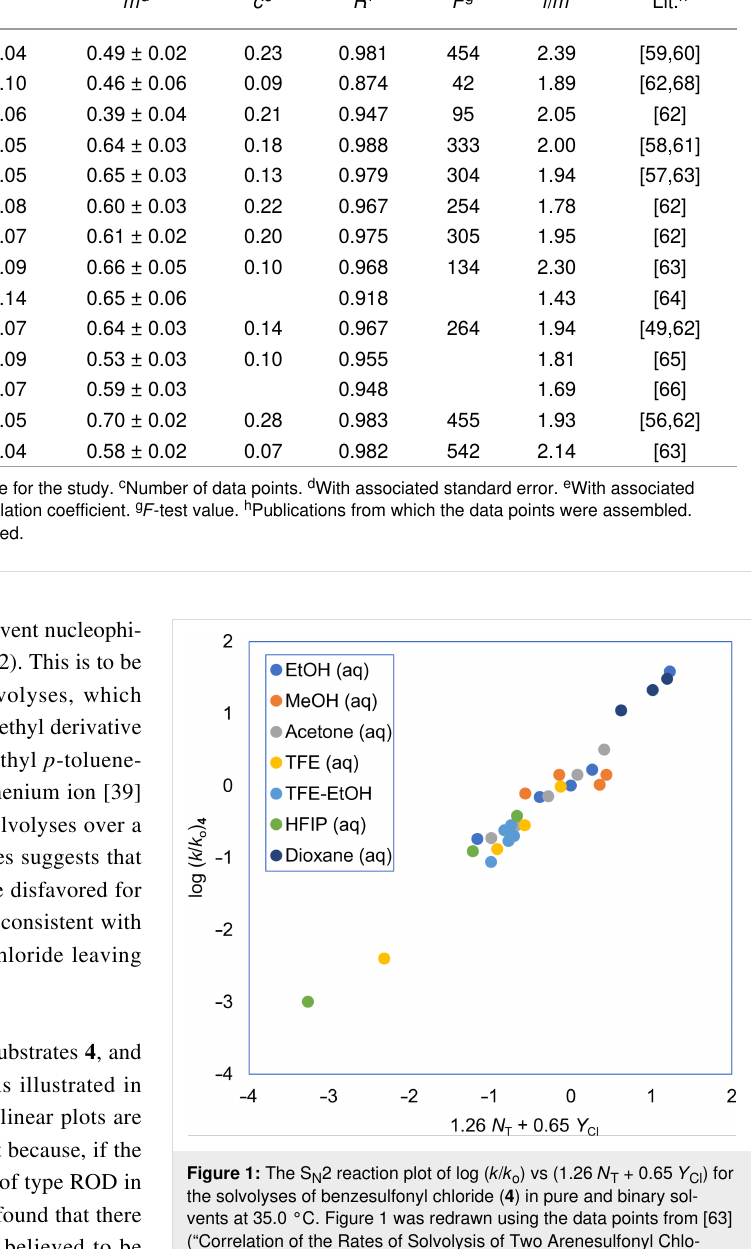
Table 2: Correlation of the specific rates of solvolytic displacement of chloride ions by nucleophilic interaction at the sulfur of sulfonyl chlorides (RSO 2 Cl) whose structures are tabulated and related to compound numbers in Table 1.